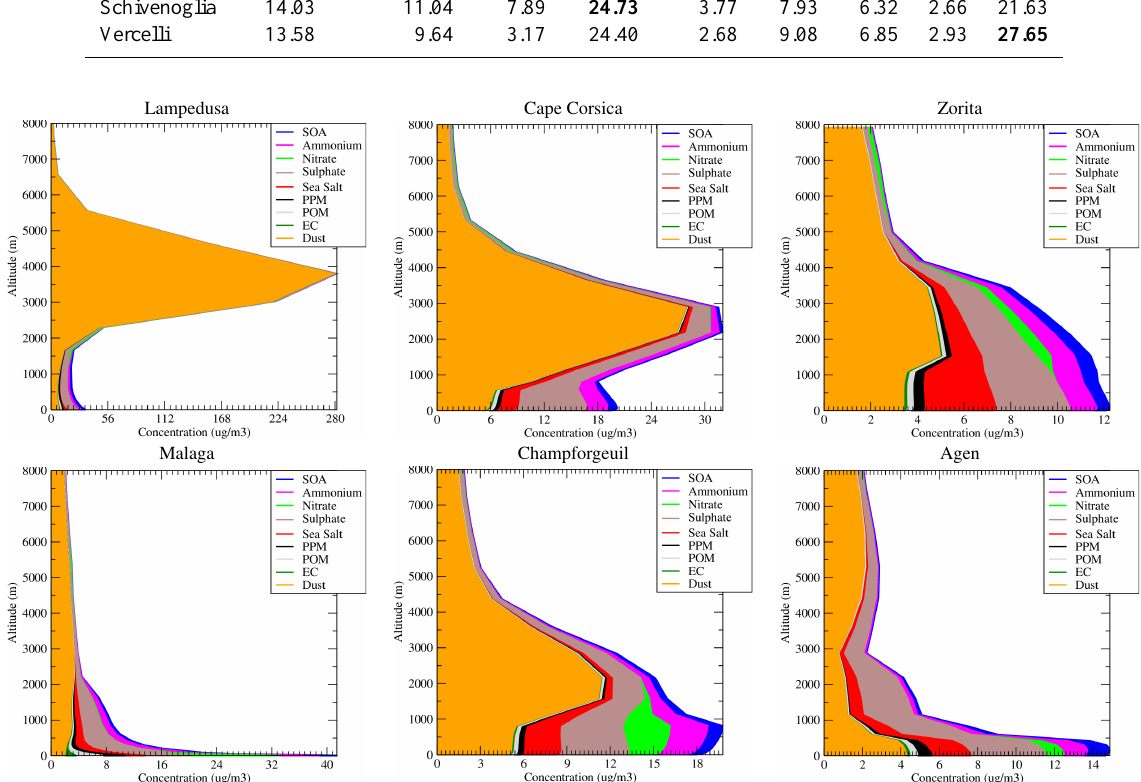
Figure 17. Vertical profiles of all modeled aerosols for 21 June 2013. Results are presented for the ADRIMED sites (Lampedusa and Cape Corsica) and some selected AirBase sites, continental and coastal stations. Note that the abscissa is different in each plot to better see the